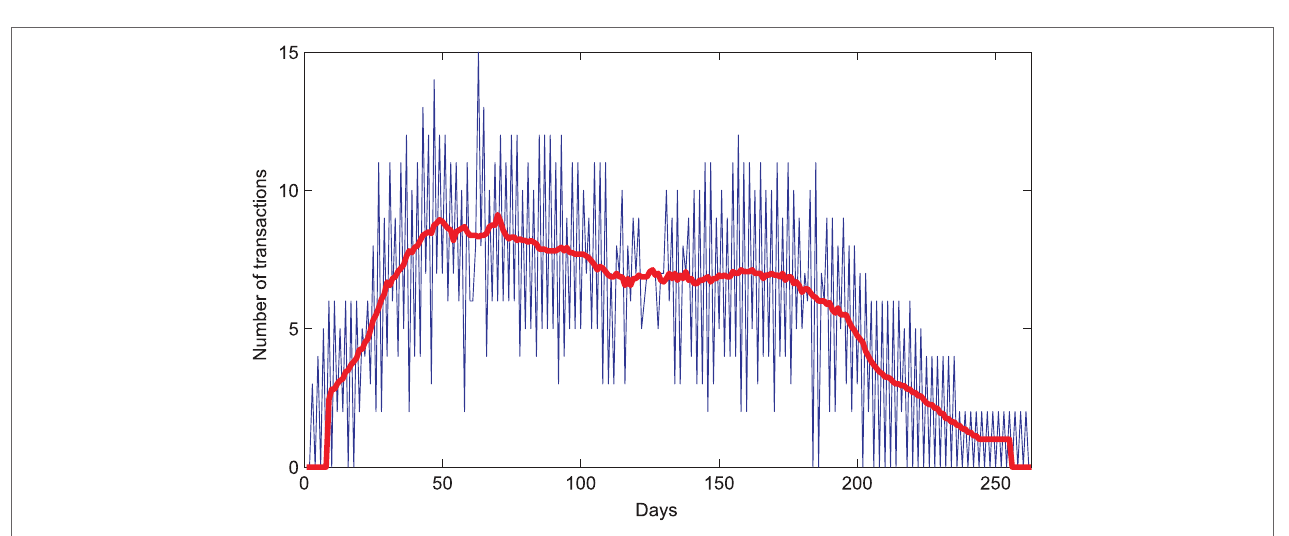
FigUre 17 | example of transactions between agents in time . Each circle represents one transaction. The positions of the circles correspond to days and the type of agents selling goods. The colors of the circles represent the types of agents buying goods as follows: green represents Farmers, yellow – Millers, red – Bakers, and blue – Sellers.